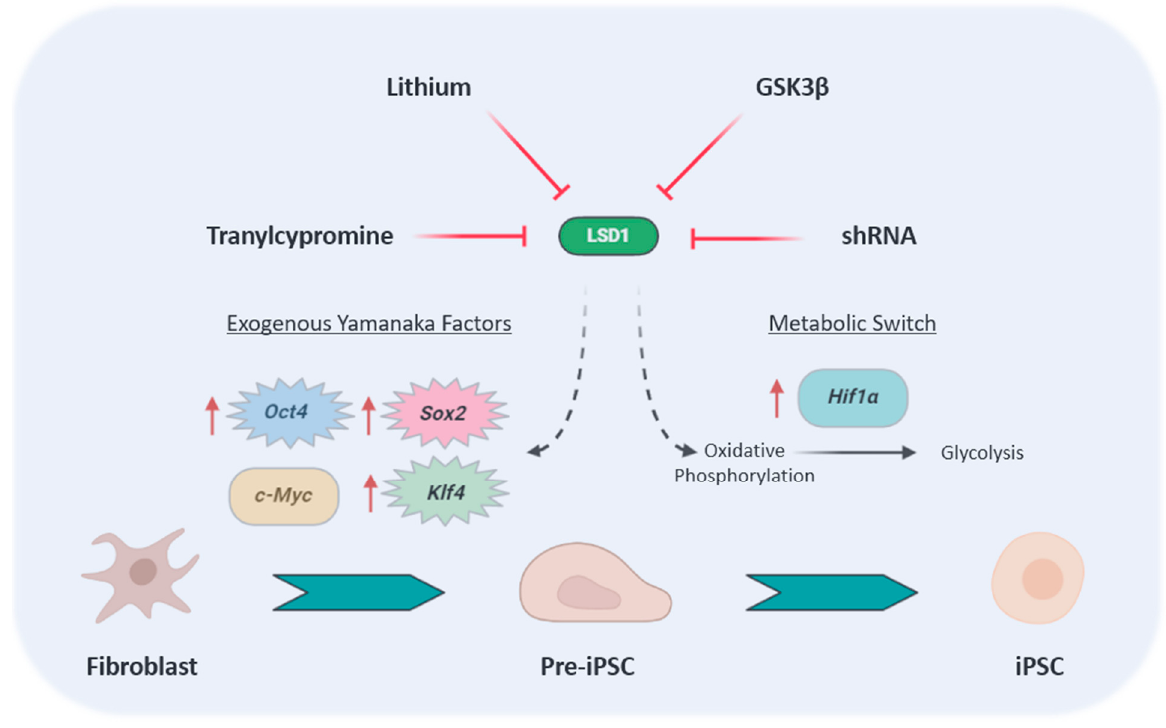
Figure 4. Function of LSD1 in reprogramming. LSD1 depletion by tranylcypromine, lithium, GSK3 β or shRNA promotes iPSC reprogramming by two different pathways. Firstly, LSD1 inhibition enhances the exogenous expression of the Yamanaka factors, stimulating the conversion of fibroblast to pre-iPSC. Secondly, LSD1 inhibition leads to a metabolic switch from oxidative phosphorylation to glycolysis by rescuing Hif1 α expression which promotes the conversion from pre-iPSC to iPSC [108].